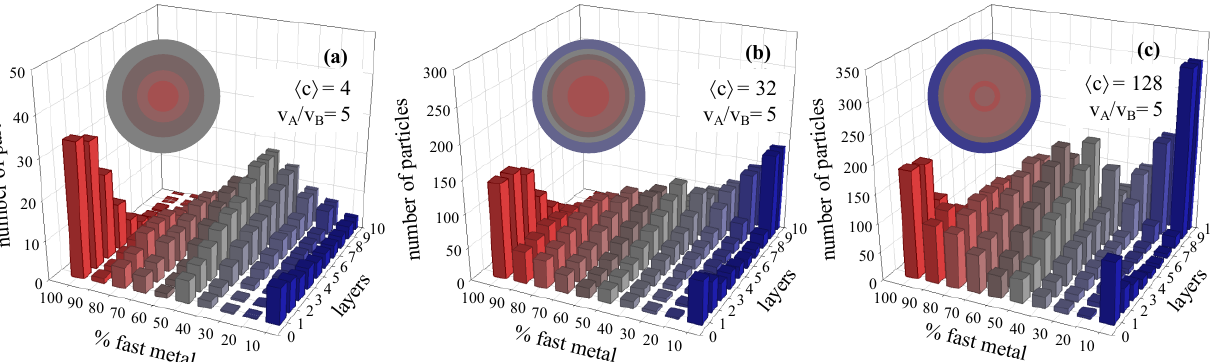
Figure 3. Histograms represent the number of particles with a given percentage of the faster metal A in each layer, from the nanoparticle core to the surface. Synthesis conditions: reduction rate ratio v A /v B = 5; film flexibility ( k ex = 5, f = 30). ( a ) Metal salt concentration  c  = 4 metal ions in a micelle; ( b )  c  = 32 metal ions in a micelle; ( c )  c  = 128 metal ions in a micelle. Scheme color: blue (0%–45% of A), grey (45%–55% of A), red (55%–100% of A). Less red means less A (faster metal). Circles in each histogram represent nanoparticle structure in concentric layers, keeping the same color